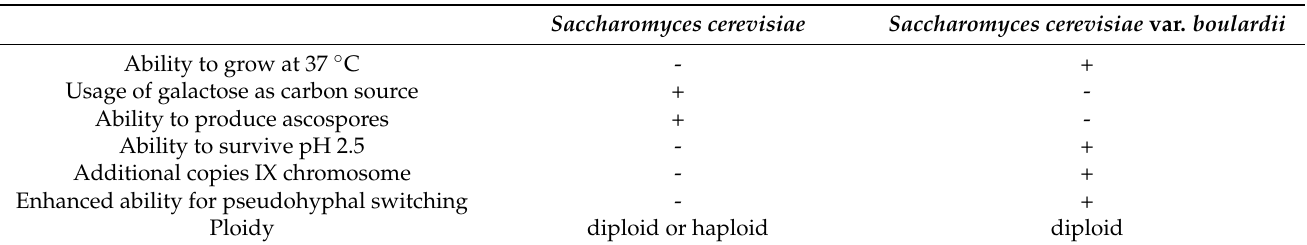
Table 1. Differences between Saccharomyces cerevisiae and Saccharomyces cerevisiae var. boulardii. Saccharomyces